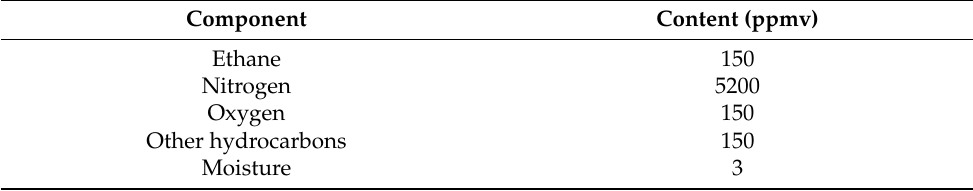
Table 2. Methane impurities of methane CP grade